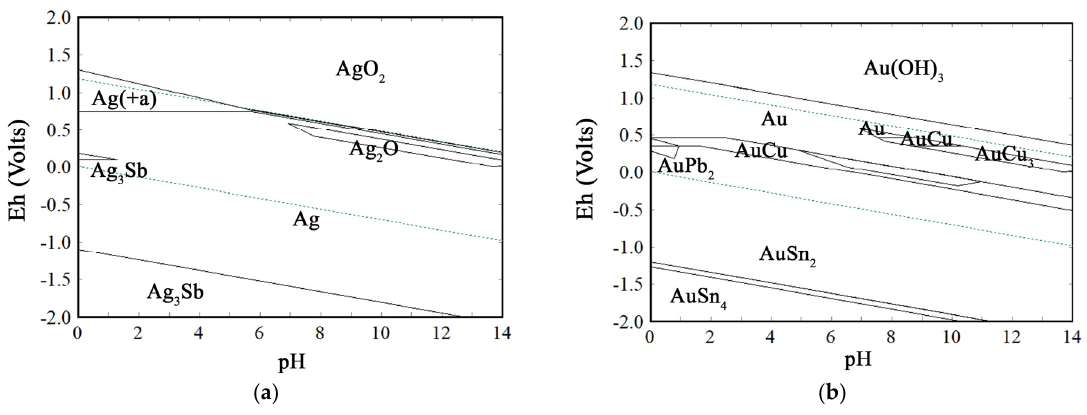
Figure 3. Pourbaix diagrams (Eh ‐ pH) for 1 mol/dm 3 (metal)/kg H 2 O and P θ : ( a ) Ag; ( b ) Au.